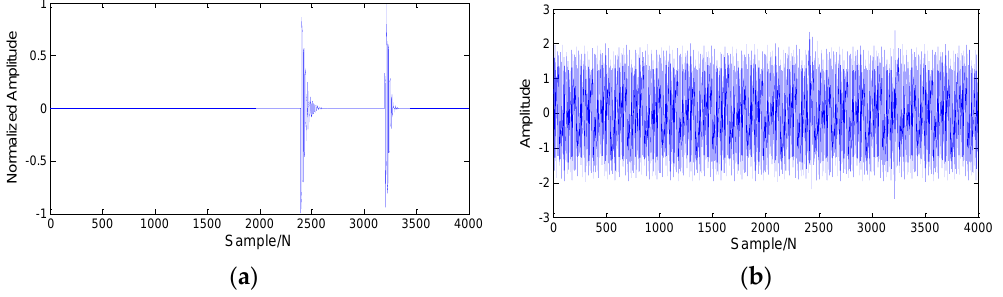
Figure 3. Simulated PD signal waveforms: ( a ) Noise-free PD waveform based on (16) and (17); and ( b ) Noisy PD waveform with Gaussian white noise and periodic narrowband noise providing an signal-to-noise ratio (SNR) of −6 dB.